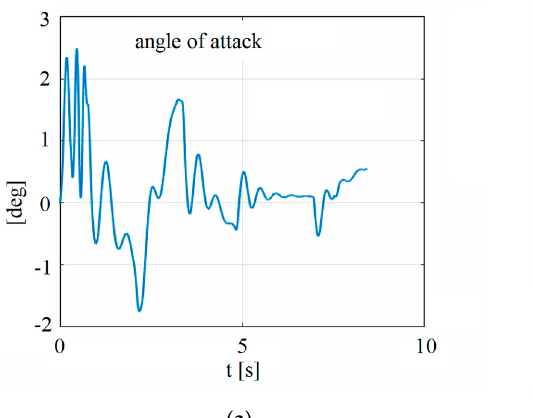
in the horizontal plane.